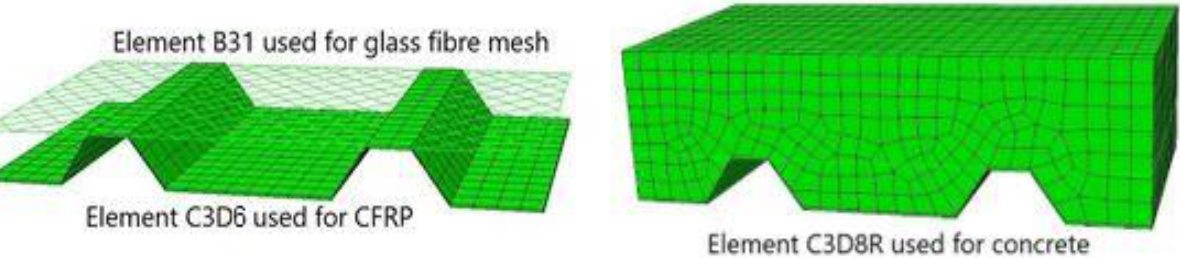
Figure 8. Geometry and boundary conditions.